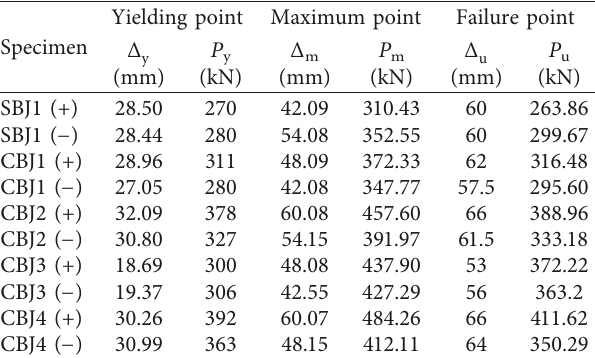
Figure 16: Key points on the skeleton curve. Table 4: Experimental results.